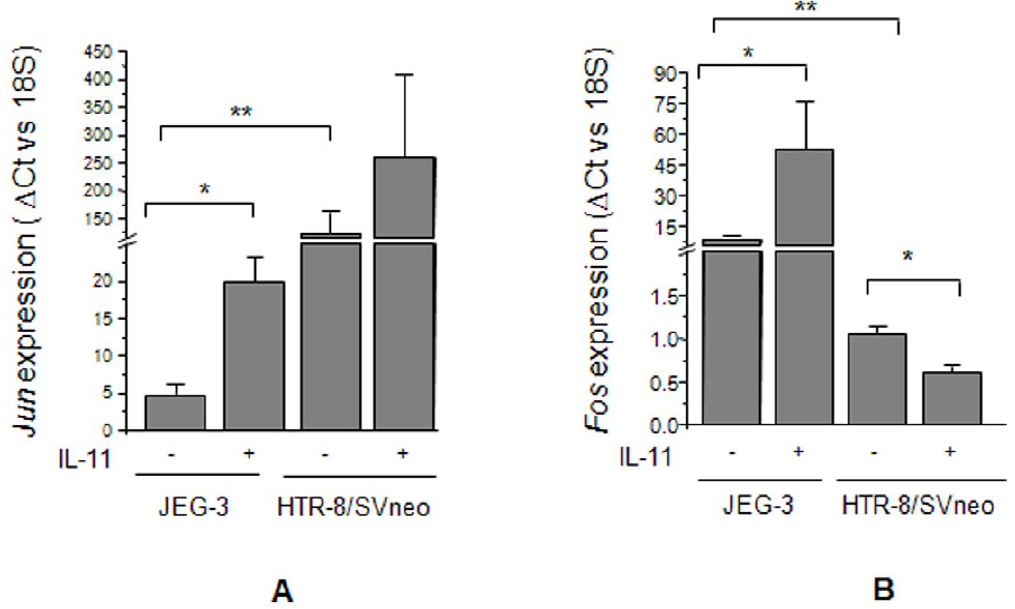
Figure 3. IL-11 mediated expression of Jun and Fos in JEG-3 and HTR-8/SVneo cells. Quantitative RT-PCR was done for the expression of Jun (Panel A) and Fos (Panel B) as mentioned in Materials and Methods . Each bar represents the D Ct values after normalization with the 18S rRNA. The data is expressed as mean 6 SEM of 3 experiments performed in triplicates. *p , 0.05; **p , 0.001.